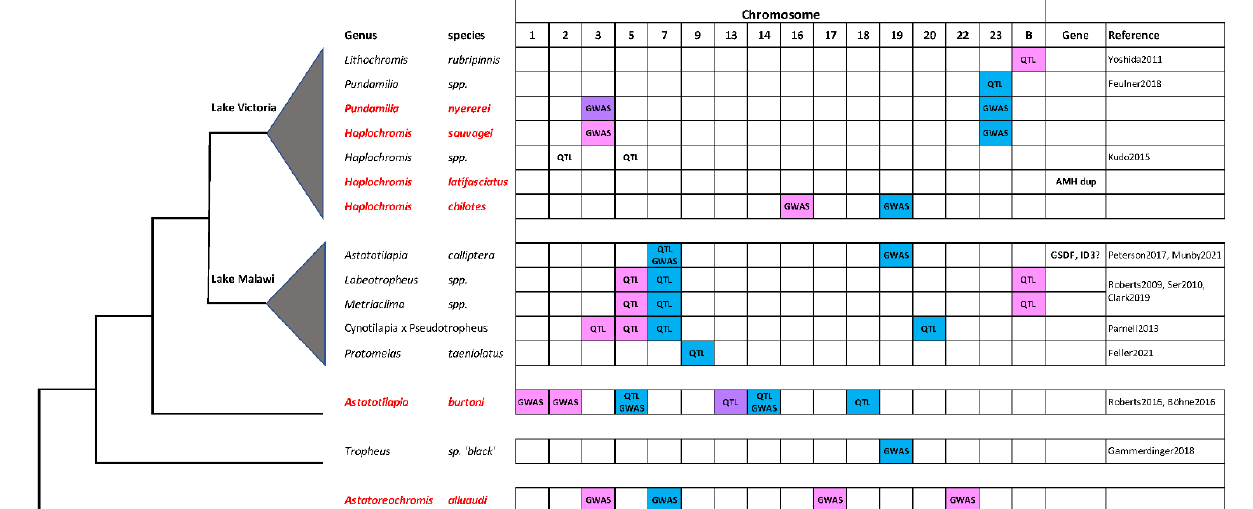
Figure 4. Sex chromosomes in the Haplochromini. The phylogenetic relationships of some haplochromine species are shown on the left. The species studied in this paper are listed in red. Blue boxes indicate XY systems, pink boxes indicate ZW systems, and purple boxes indicate instances of XY and ZW variation on the same chromosome in P. nyererei and A. burtoni . Support from QTL or genome wide association studies (GWAS) is indicated, and candidate genes are listed to the right.